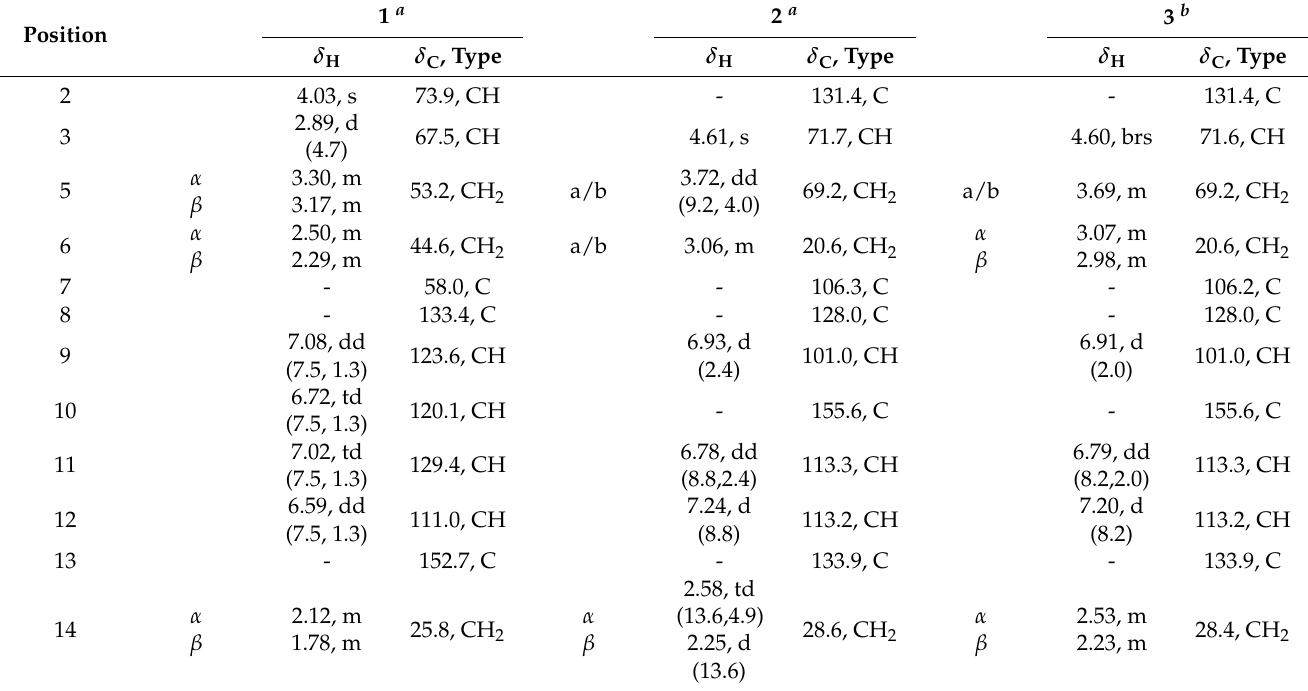
Table 1. NMR data of 1–3 (CD 3 OD, δ in ppm, J in Hz).